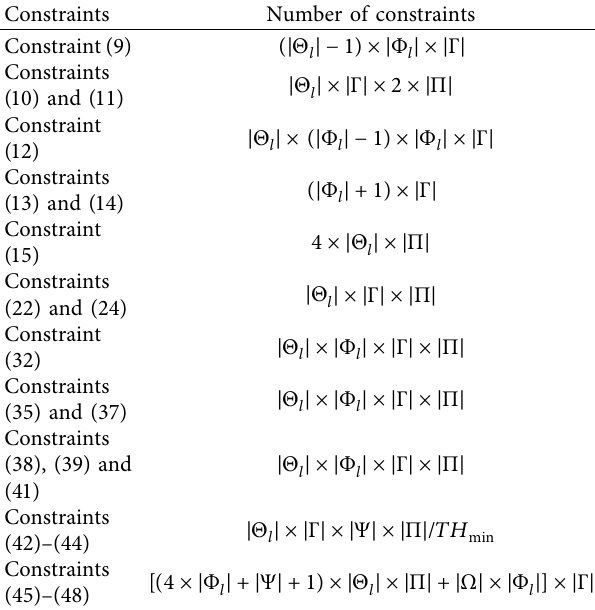
Table 3: The number of constraints in the PCS&TOP model.